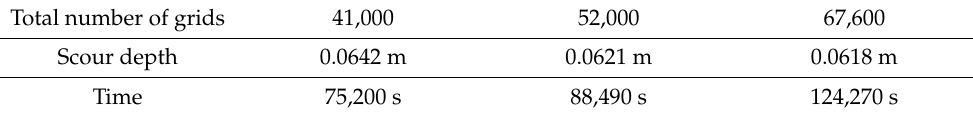
Table 1. Mesh grid.